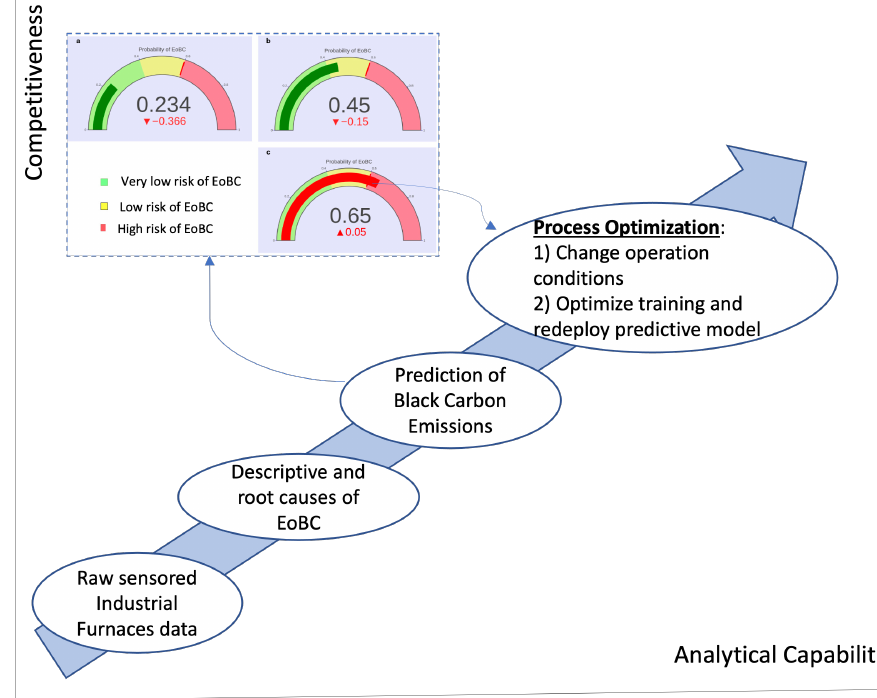
Figure 6. Optimization to elevate analytical capabilities and